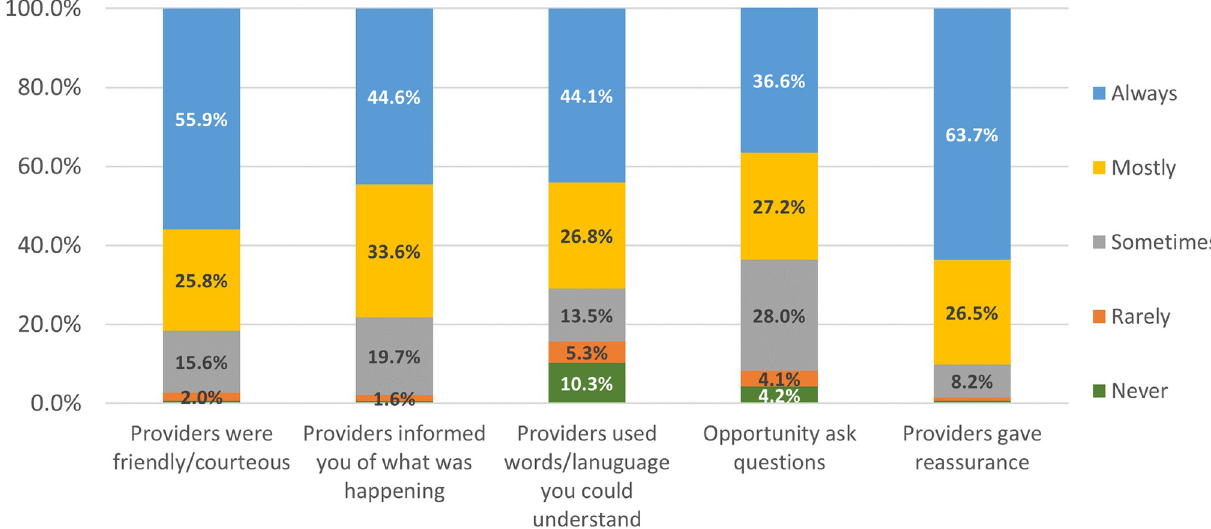
Fig 2. Self-reported experiences with care among 2313 women diagnosed with PPH at secondary level health facilities in Uganda, Egypt, and Senegal.